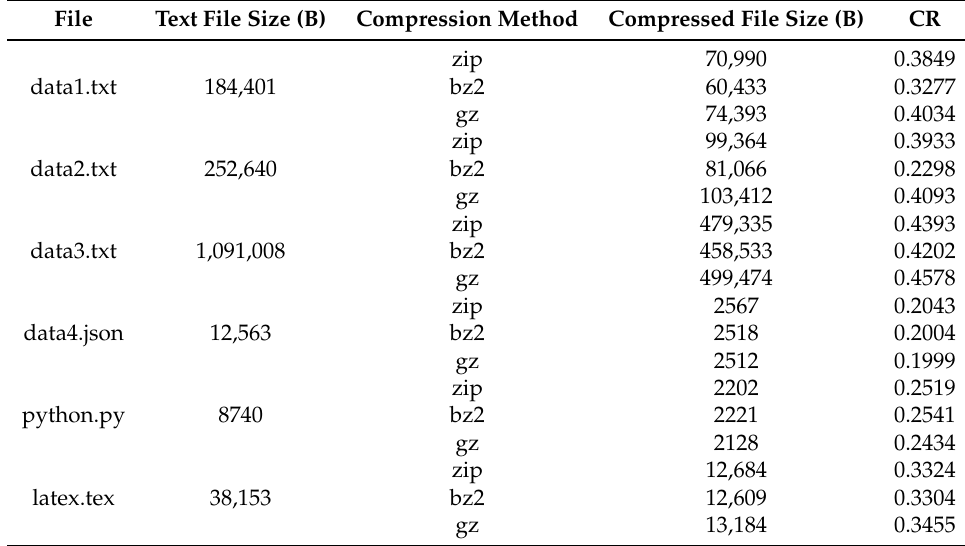
Table 3. Results for selected test files using different file compressing methods. The list of columns includes filename, size of the text file, compression method, size of the compressed file and